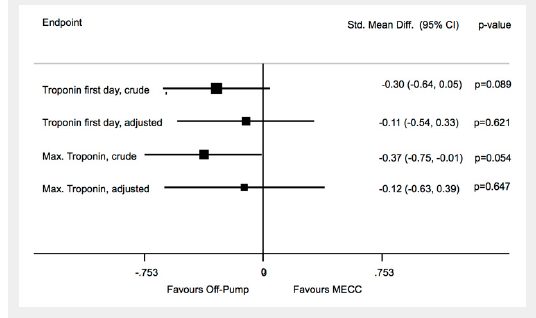
Forest plot regarding the values of TrT on the first postoperative day and the highest values of